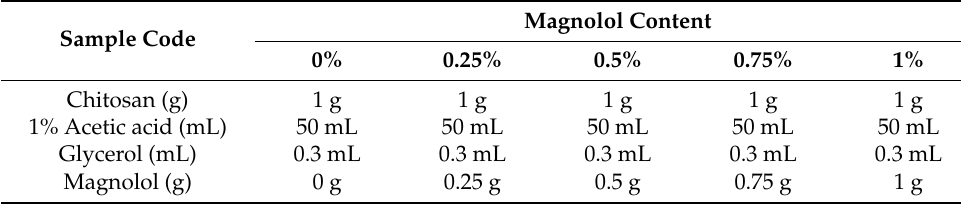
Table 2. The compositions of magnolol–chitosan